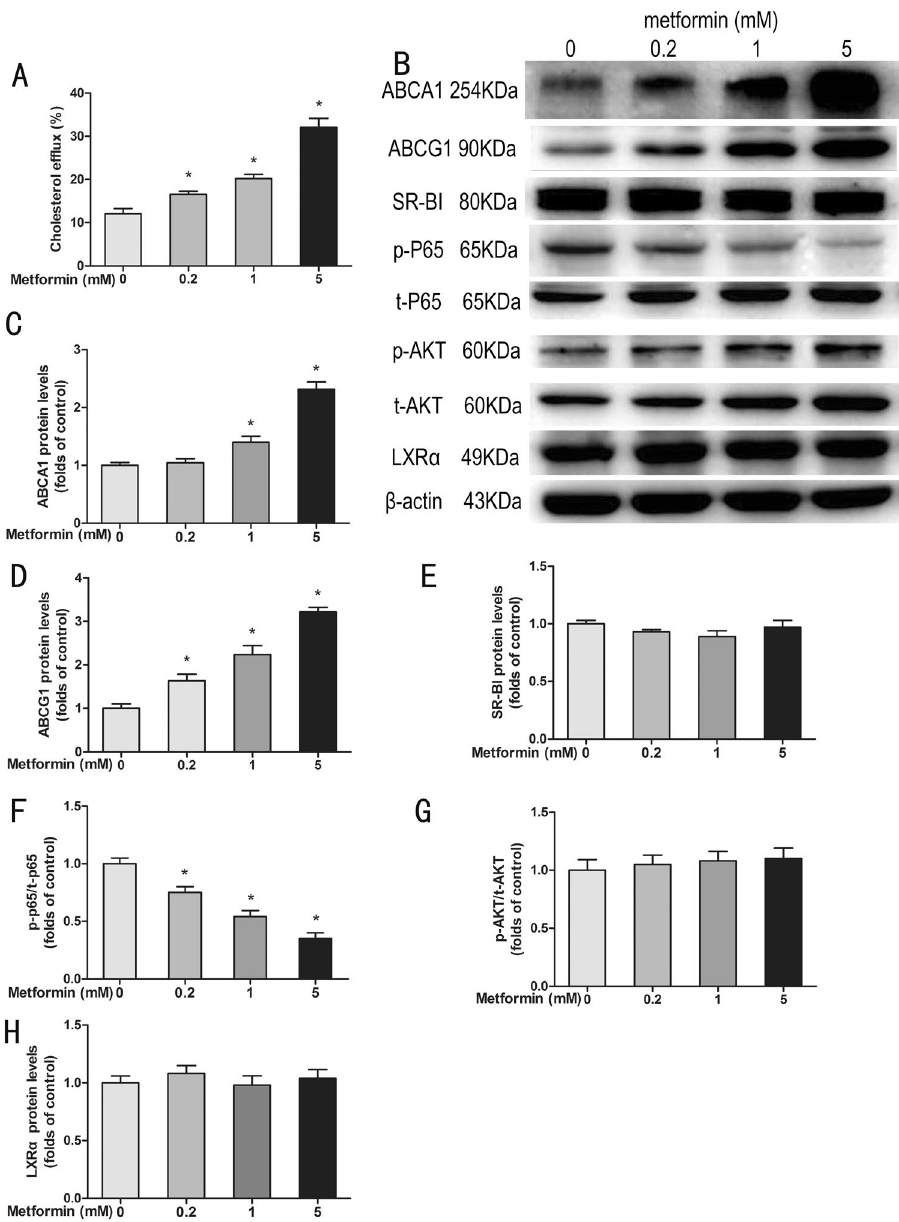
Figure 4. Metformin improves cholesterol efflux and ATP-binding cassette transporters expression in vitro . After loading with acLDL (50 μ g/mL) and 3 H-cholesterol (0.5 μ Ci/mL) for 24 h, THP-1 macrophages were incubated with 5% apoB-depleted serum and different concentrations of metformin (0, 0.2, 1 and 5 mmol/L) for a further 24 h. Cholesterol efflux was expressed as the percentage of radioactivity in the medium relative to the total quantity of radioactivity detected in the cells and medium ( A ). Examples of cholesterol efflux-related proteins tested by Western blot after 24 h metformin treatment ( B ). Relative protein levels of ABCA1 ( C ), ABCG1 ( D ), SR-BI ( E ), p-P65/t-P65 ( F ), p-AKT/t-AKT ( G ), and expression of LXR α ( H ). Data are mean ± SD, n = 3 for each group. * P < 0.05, compared with blank control